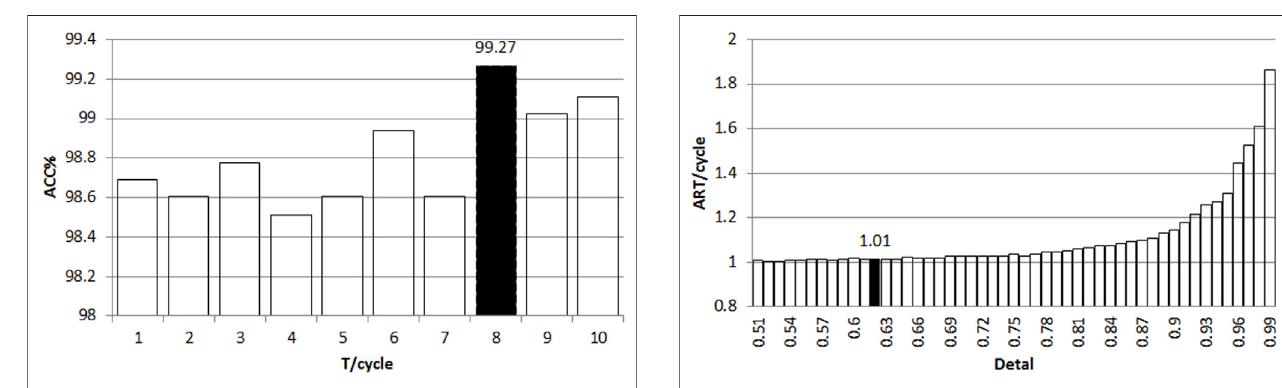
FIGURE 7 | T on the relationship of accuracy.